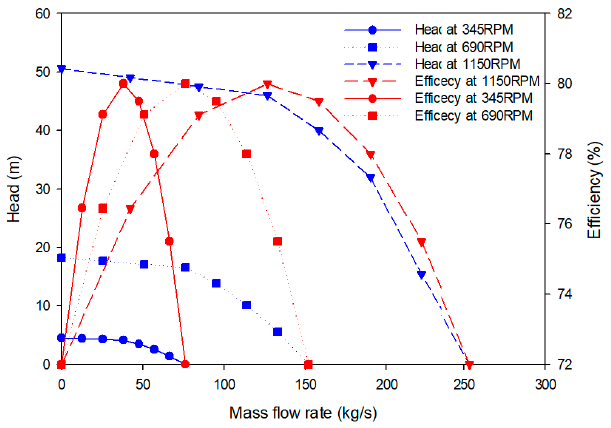
Figure 3. Pumping head and efficiency change in refrigerant pump flow rate.